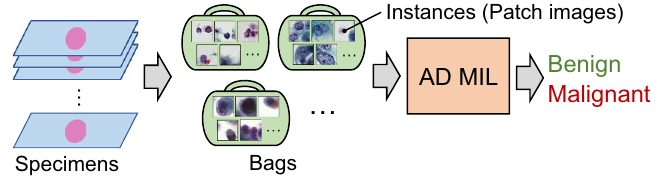
Figure 1. Schematic diagram of the proposed